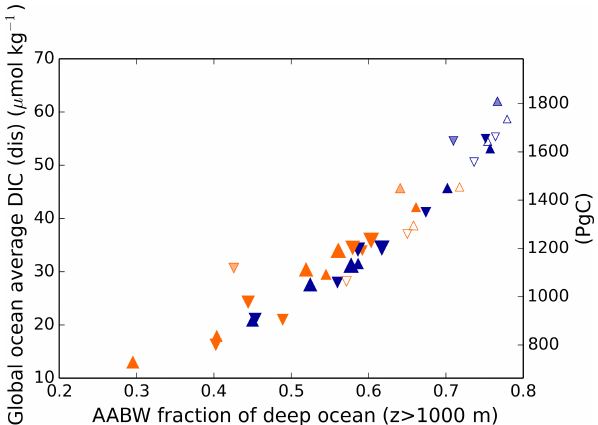
Figure 6. Global average DIC dis as a function of the fraction of the ocean below 1km derived from the surface Southern Ocean. Orange and blue symbols represent high and low obliquity scenar- ios, respectively; triangles pointing upward and downward repre- sent greater Northern and Southern hemisphere seasonality (preces- sion 270 and 90 ◦ ); outlines are scenarios with LGM ice sheets; light shading indicates scenarios with LGM ice sheet topography but PI albedo. The size of the symbols corresponds to the